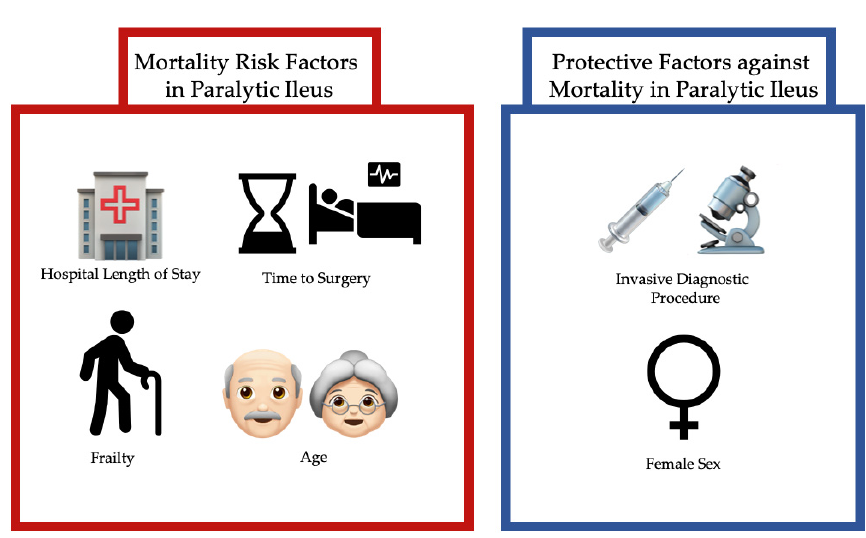
Table 7. Comparison of variables used for estimating 5-item modified frailty index (mFI).